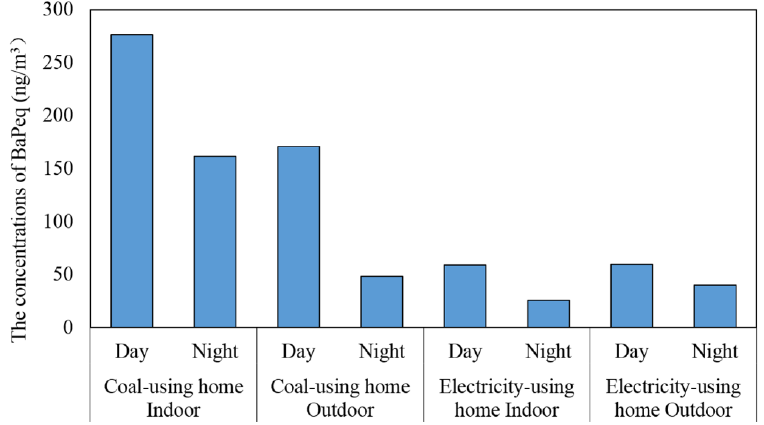
Figure 5. Distribution of BaP eq in the homes in the Hutou village of the Laibin town, Xuanwei